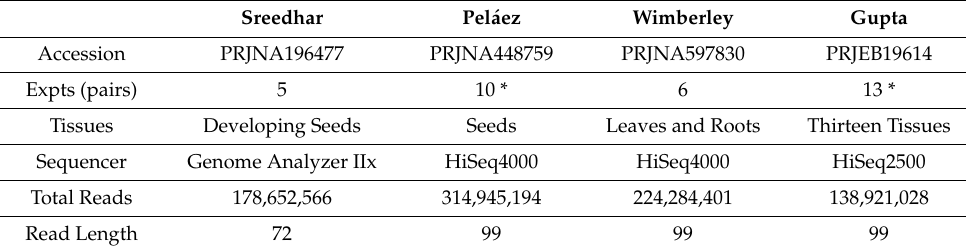
Table 1. Trinity assembled each of four different chia RNA-Seq studies